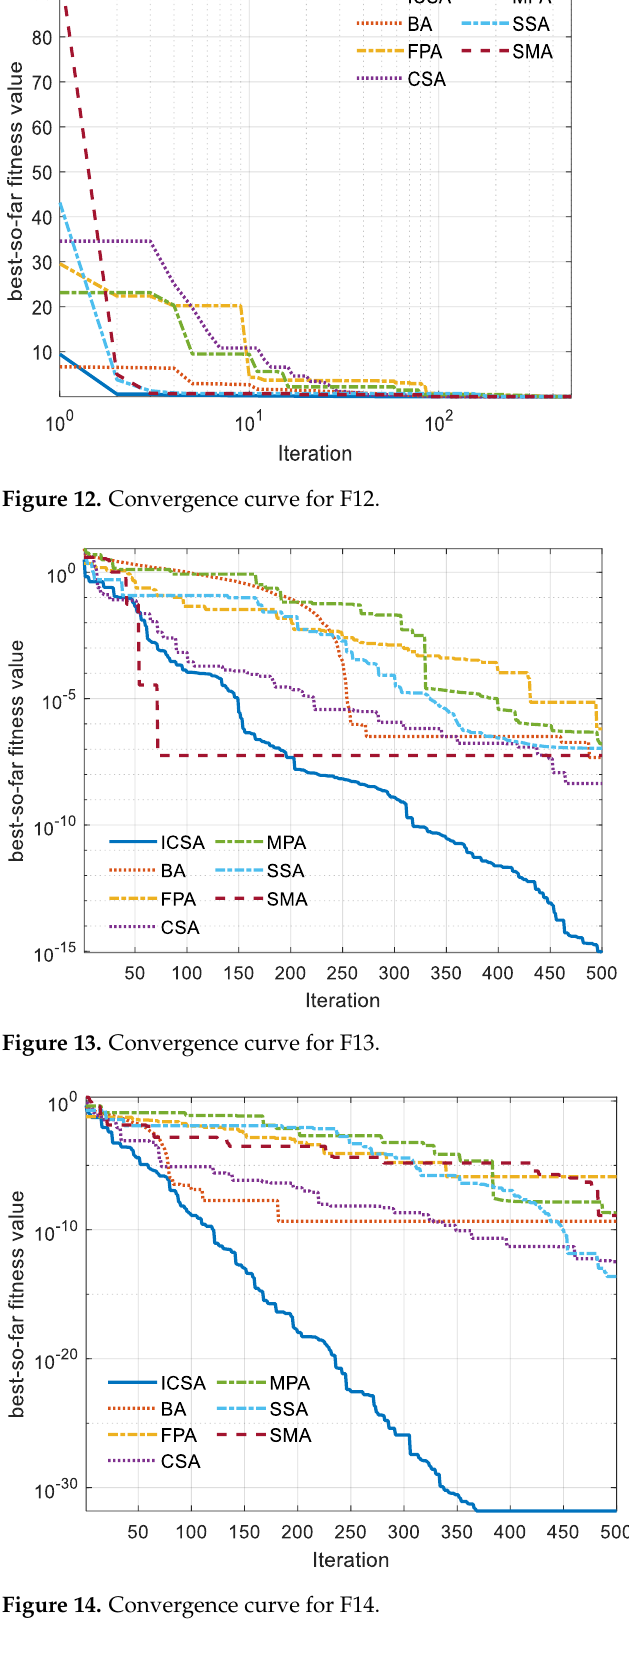
Figure 11. Convergence curve for F11.